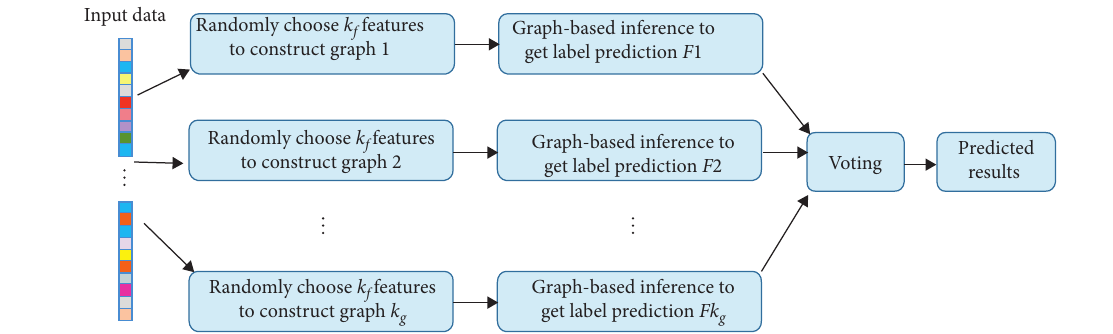
Figure 1: Implementation of LBP FE.